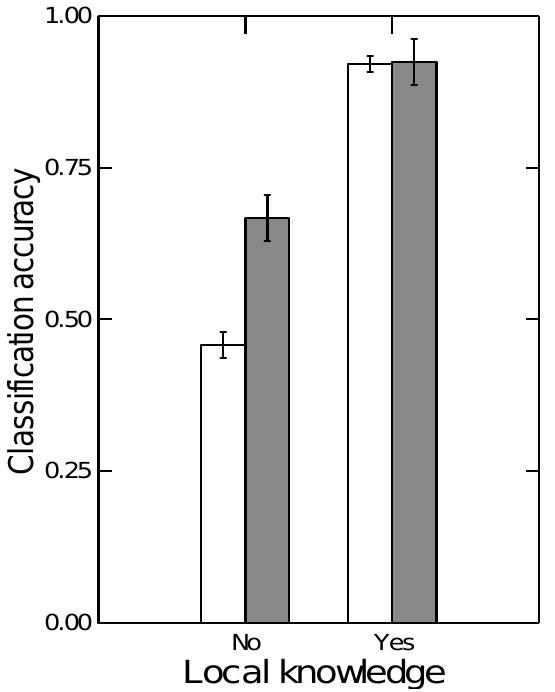
Figure 4. Classification accuracy (with standard error) for interpreters with and without local knowledge and with (grey) and without (white) surveying skills.